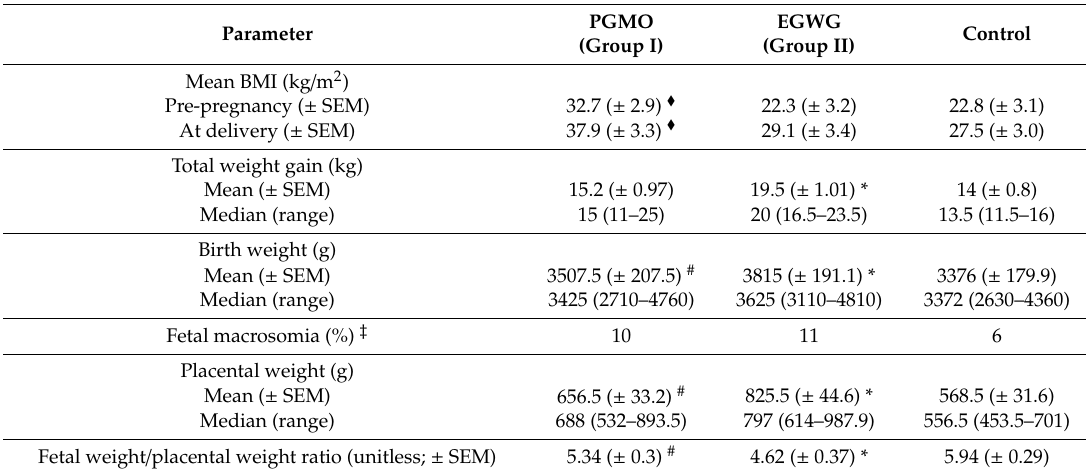
Table 3. Comparison of selected parameters related to term pregnancy and perinatal period between three groups of pregnant